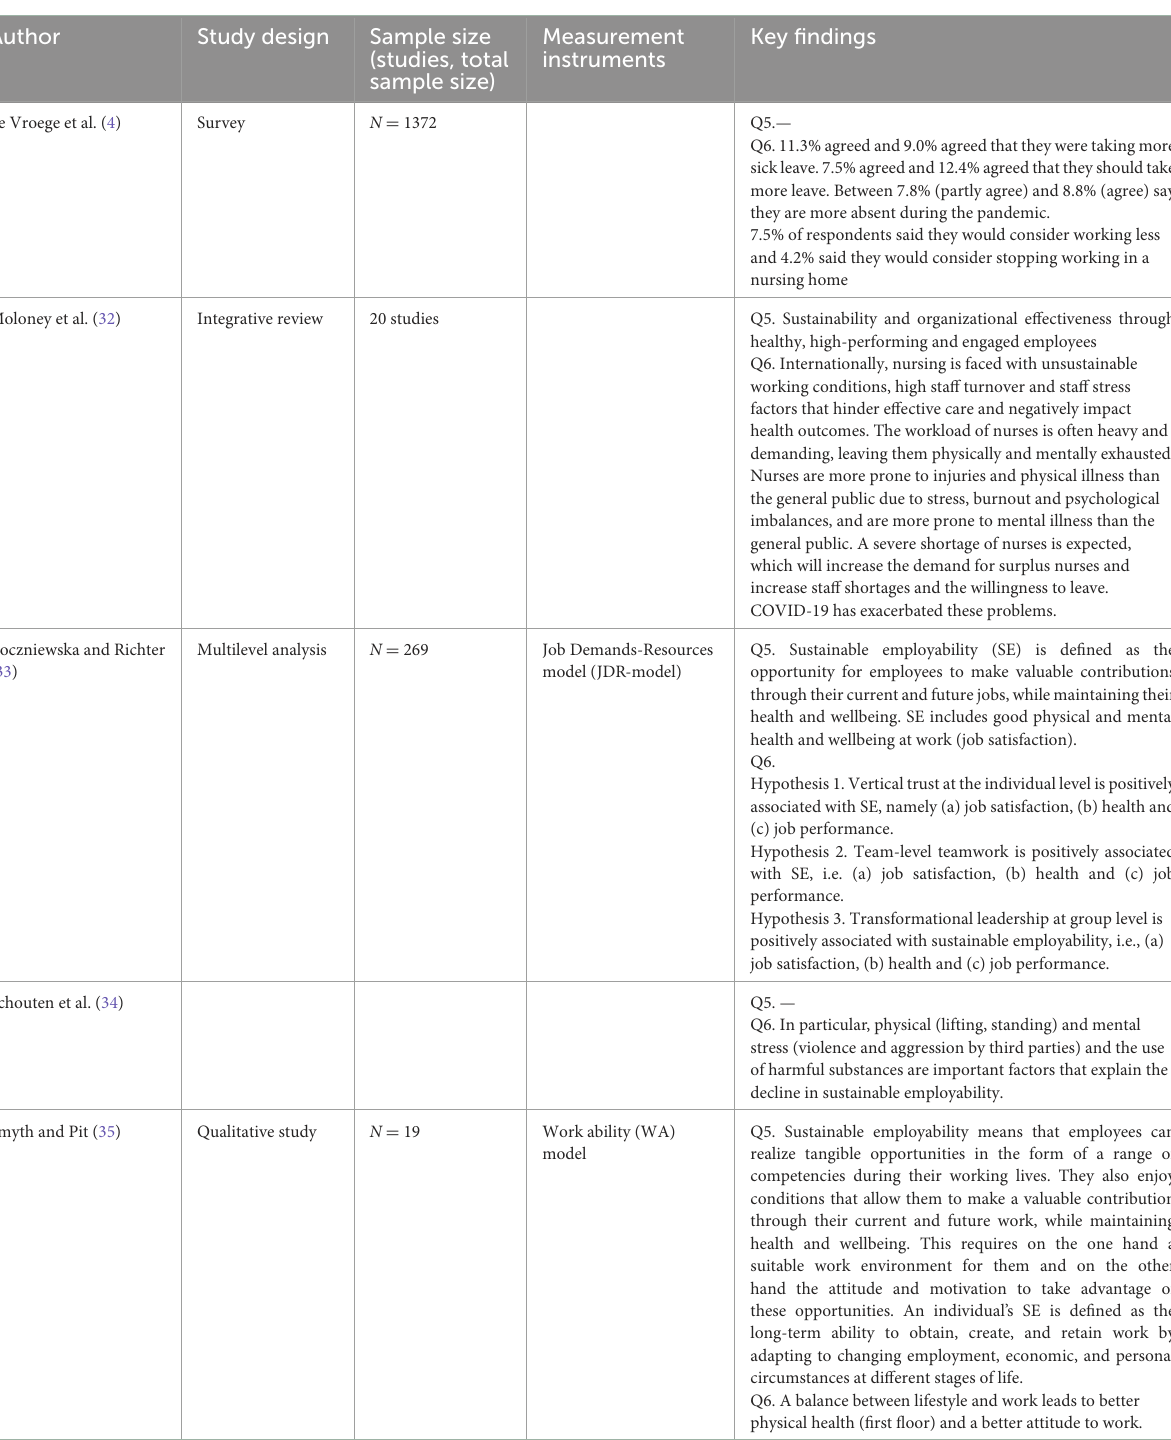
TABLE 2C Overview of the characteristics of the studies answering Q5 and